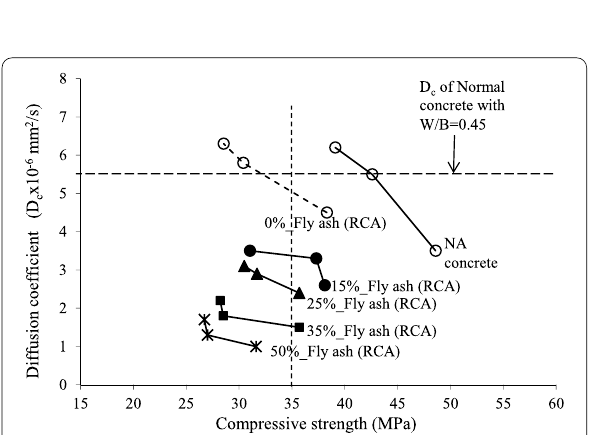
Fig. 7 Relationship between compressive strength at 28 days and D c of NA and RCA concretes after being exposed to seawater for 7